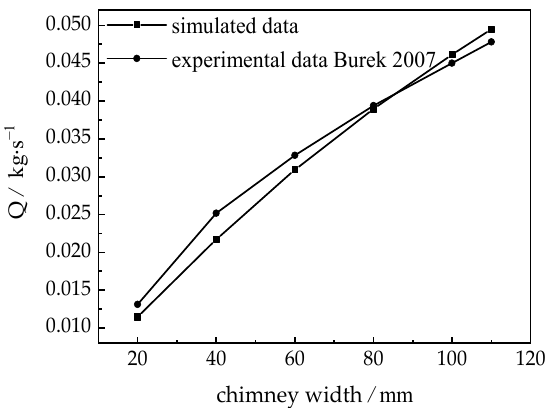
Figure 5. Comparison of the experimental data and the simulated data [20].